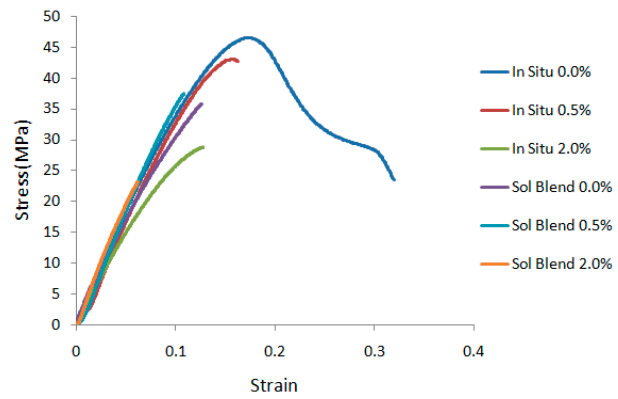
Figure 8. Stress-strain curves for various nanocomposites prepared by in situ polymerization and solution blending method. Table 1. Mechanical properties for neat PMMA and its nanocomposites.